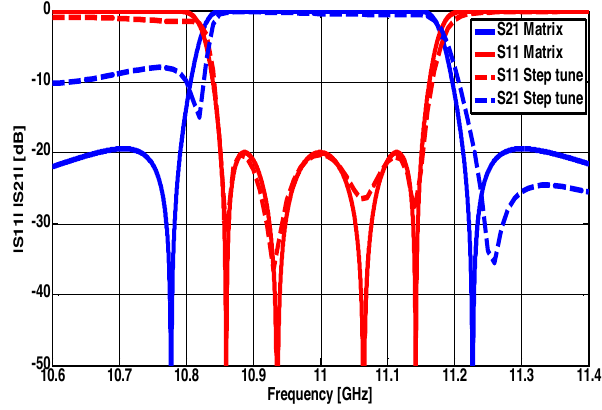
FIGURE 11. Step four: EM response of tuned results (solid lines) and target results (dashed